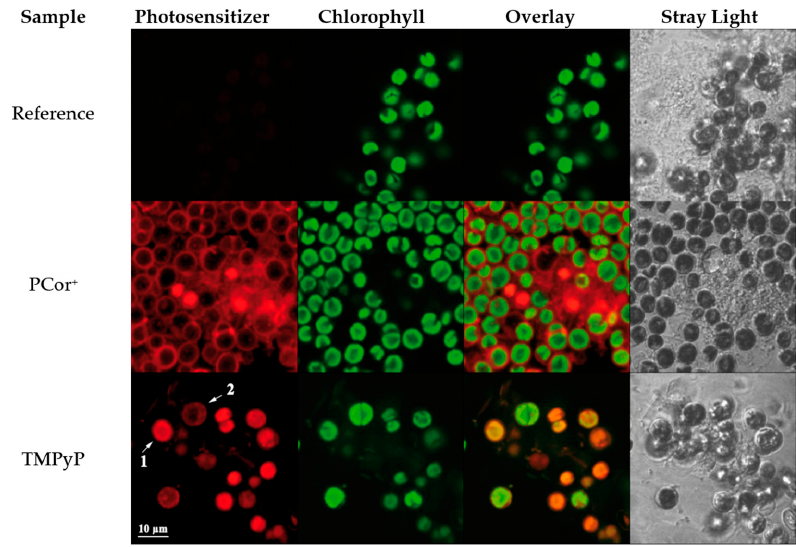
Figure 7. Localisation of the photosensitizer in Chlorella fusca var. vacuolata after three days of incubation. PCor + appears to locate outside the algae cells while TMPyP appears to accumulate inside the algae cells.